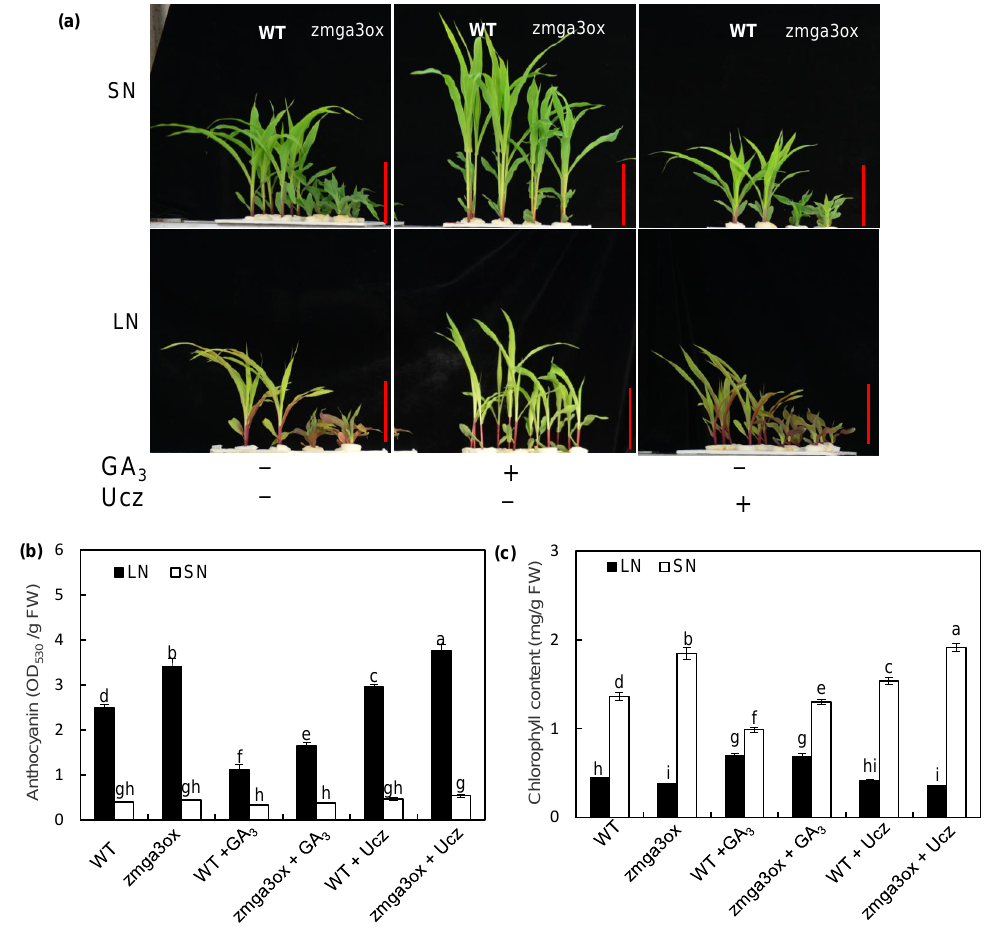
Figure 2. The anthocyanin accumulation and chlorophyll content in zmga3ox leaves under LN or SN condition. ( a ) Appearance of the GA 3 or Ucz-treated wild-type and zmga3ox leaves at 7 d after LN or SN treatment. Bar = 10 cm. ( b ) The content of anthocyanin in zmga3ox shoots treated with GA 3 or Ucz at 7 d after LN or SN treatment. Values were the means ± SD ( n = 3). ( c ) The content of chlorophyll in zmga3ox shoots treated with GA 3 or Ucz at 7 d after LN or SN treatment. Values were the means ± SD ( n = 3). Di ff erent letters indicated significant di ff erence calculated by Fisher’s LSD ( p <